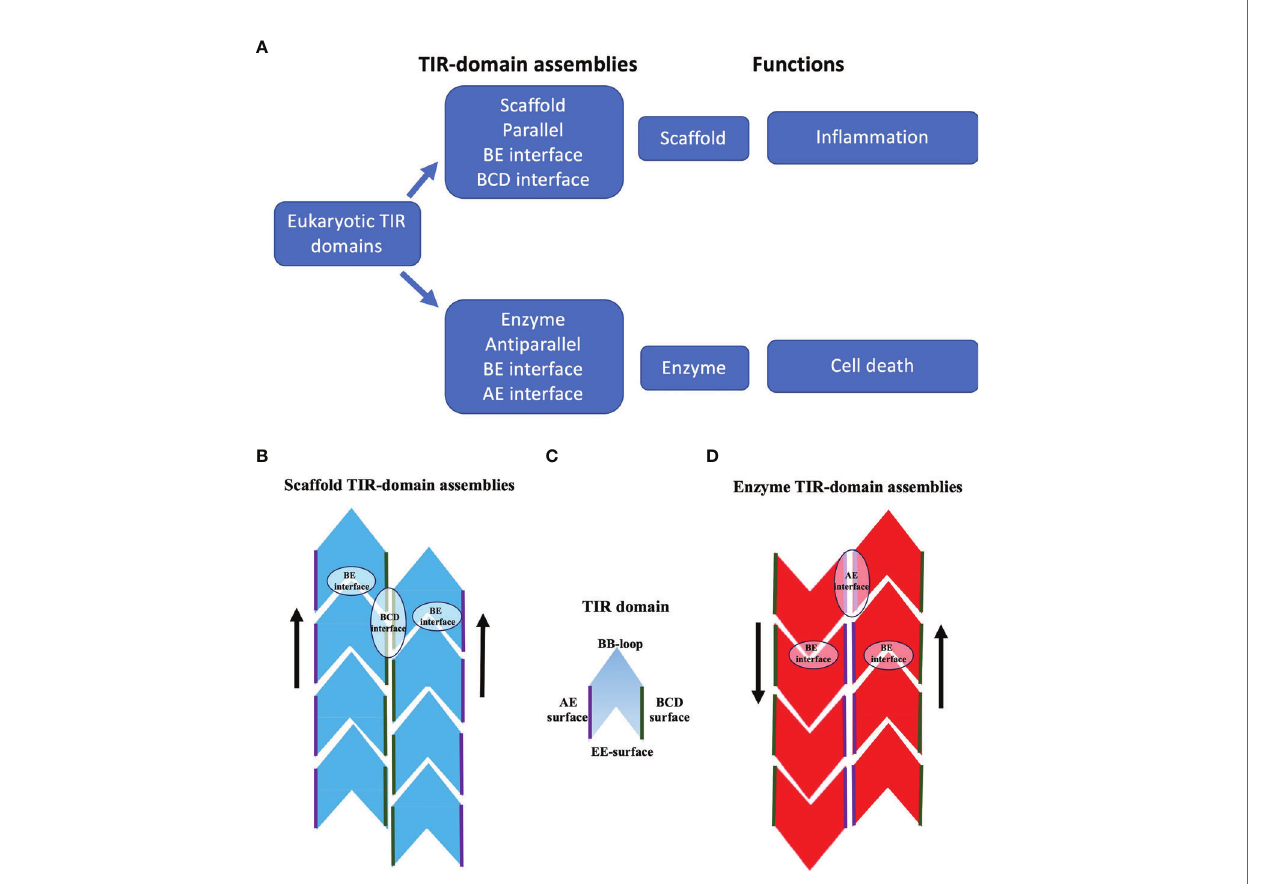
FIGURE 4 | Schematic representation of TIR-domain assemblies. (A) Overview of TIR-domain assemblies. (B) Scaffold TIR-domain assemblies, represented by the structures formed by the TIR domains from human MAL and MyD88. These parallel two-stranded assemblies are held together by the intrastrand BE interfaces, and the interstrand BCD interfaces. (C) Schematic diagram of a single TIR domain, to highlight the BB-loop, BCD, EE and AE surfaces (the diagram does not differentiate the structures of TIR domains in monomeric and signalosome forms). (D) Enzyme TIR-domain assemblies, represented by the structures formed by the TIR domains from human SARM1 and the plant NLRs ROQ1 and RPP1. These antiparallel two-stranded assemblies are held together by the intrastrand BE interfaces and the interstrand AE